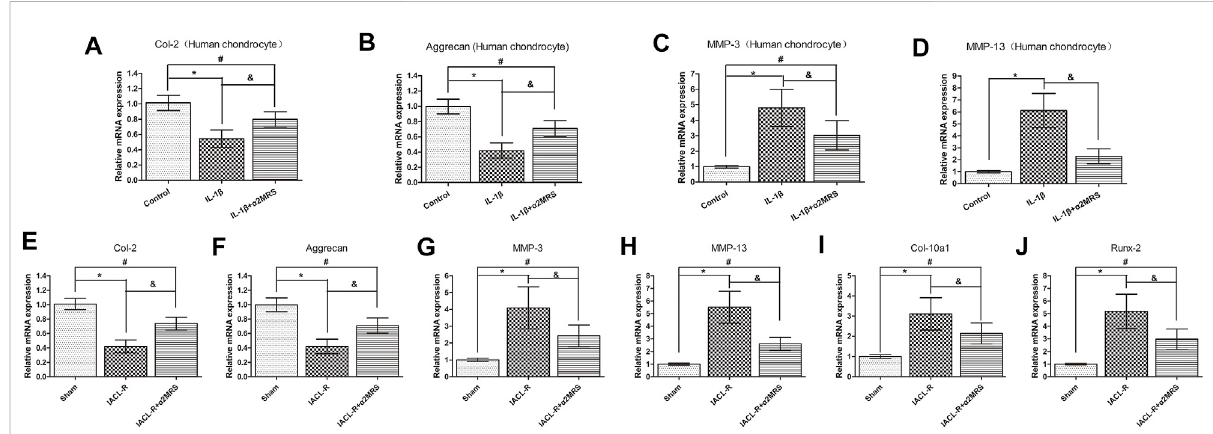
FIGURE 3 Real-time PCR data indicated that supplementation with α 2MRS reduced cartilage matrix catabolism and enhanced anabolism in-vitro (A – D) and in-vivo (E – J) . mRNA levels of MMP-3 ( p < 0.001), MMP-13 ( p < 0.001), Col-10 a1 ( p = 0.001), and Runx-2 ( p < 0.001)were lower in IL-1 β + α 2MRS and IACL-R+ α 2MRS groups than in IL-1 β and IACL-R groups respectively. In contrast, mRNA levels of Col-2 ( p < 0.001) and aggrecan ( p < 0.001) followed the opposite pattern. Both were increased in IL-1 β + α 2MRS and IACL-R+ α 2MRS groups as compared to levels in IL-1 β and IACL-R groups.*= p < 0.05,controlgroupversusIL-1 β grouporshamgroupversusIACL-Rgroup;#= p < 0.05,controlgroupversusIL-1 β + α 2MRSgroupor shamgroupversusIACL-R+ α 2MRSgroup;and= p < 0.05,IL-1 β groupversusIL-1 β + α 2MRSgrouporIACL-RgroupversusIACL-R+ α 2MRSgroup.The bars show the mean ± SD ( n = 6).